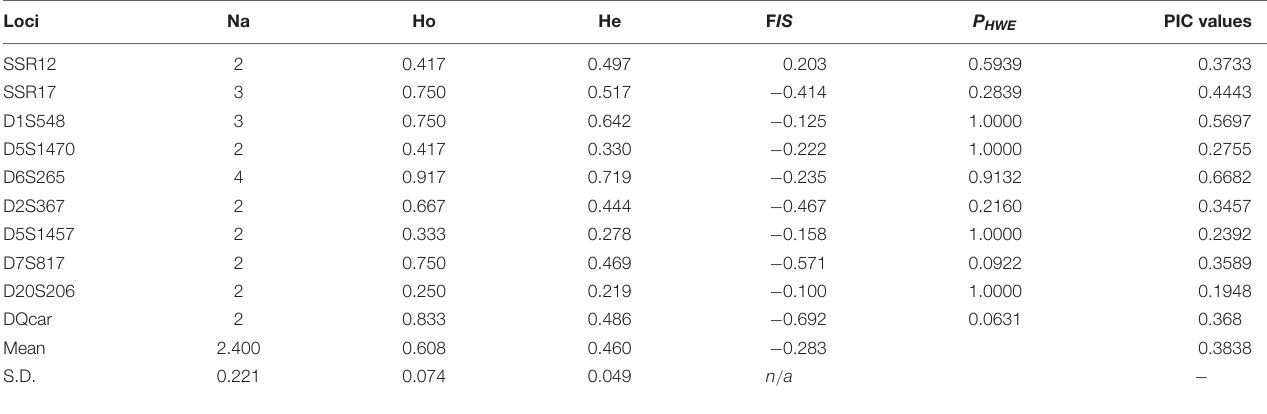
TABLE 3 | Number of alleles (Na), observed and expected heterozygosity (Ho, He), polymorphic information content (PIC), inbreeding coefficient (FIS), and Hardy–Weinberg deviation (P HWE ) for 10 selected markers with the mean and standard deviation (SD) across all